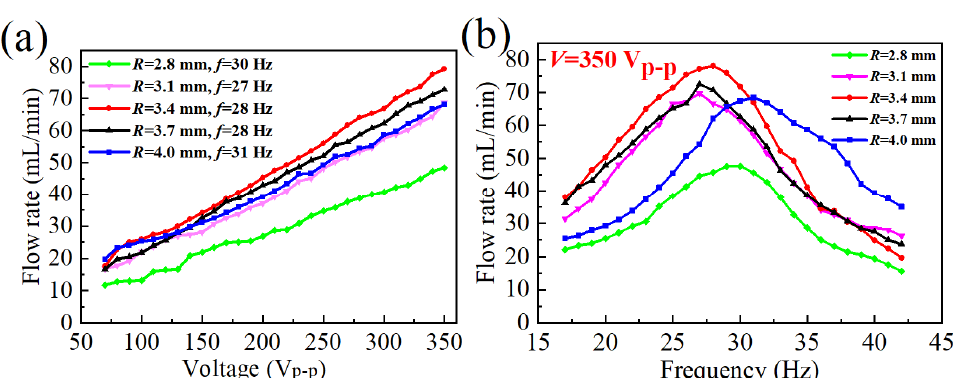
Figure 12. The trend of flow rate with the radius of the Tesla valve at different voltages and frequencies: ( a ) the voltage–flow curve; ( b ) the frequency–flow curve.